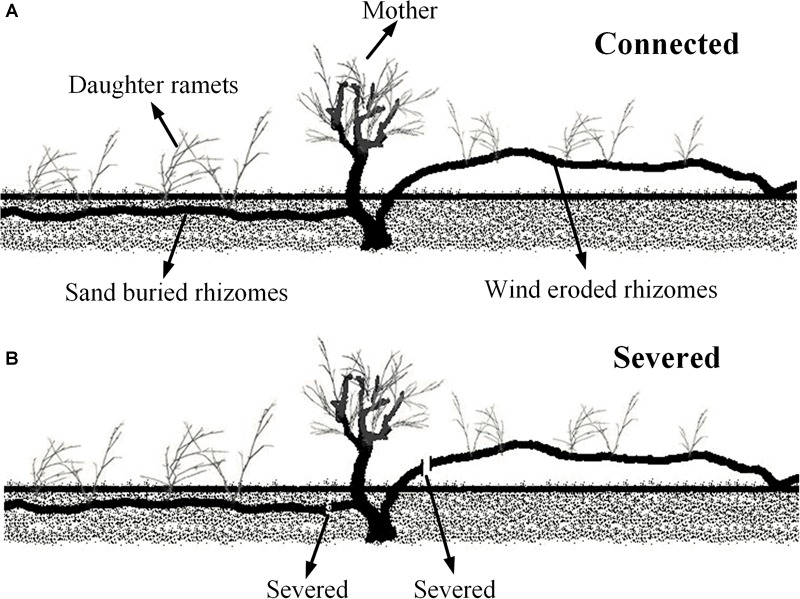
Diagram of Experiment 2. (A) Connected treatment; (B) severed treatment.